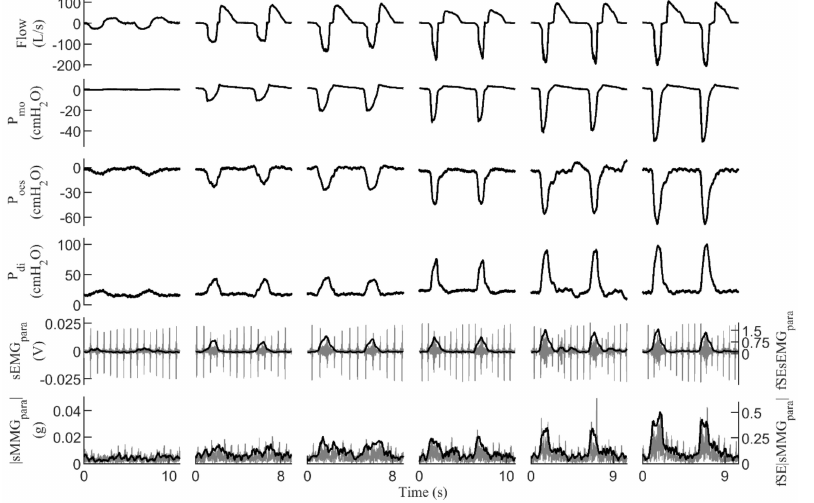
Figure 1. Signals recorded during the inspiratory threshold loading protocol in a healthy subject. Two respiratory cycles are shown for quiet resting breathing and inspiratory threshold loads at 12%, 24%, 36%, 48%, and 60% of maximal static inspiratory pressure. For the sEMG para and |sMMG para | signals, the corresponding fixed sample entropy time-series (fSEsEMG para and fSE|sMMG para | respectively) are also shown. P mo = mouth pressure, P oes = esophageal pressure, P di = transdi- aphragmatic pressure, sEMG para = surface electromyography of the parasternal intercostal muscles, |sMMG para | = surface mechanomyography of the parasternal intercostal